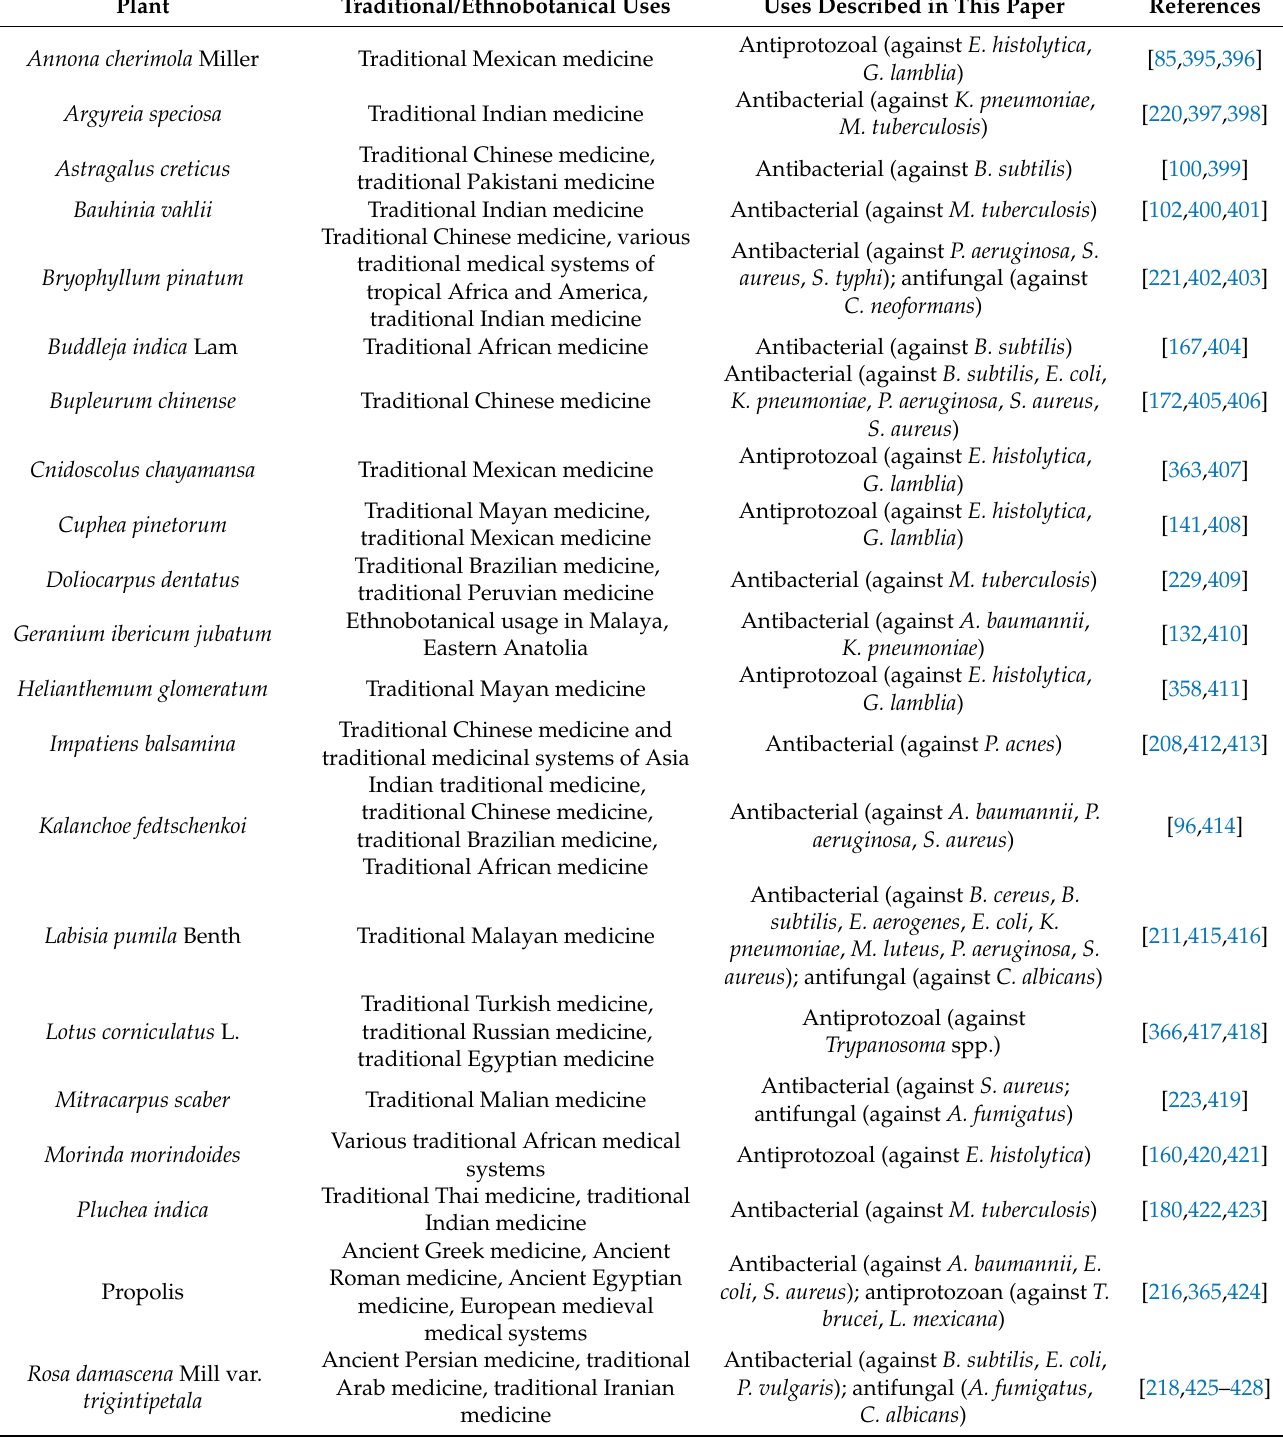
Table 7. Correlation between ethnobotanical and described uses of certain kaempferol-containing plants.